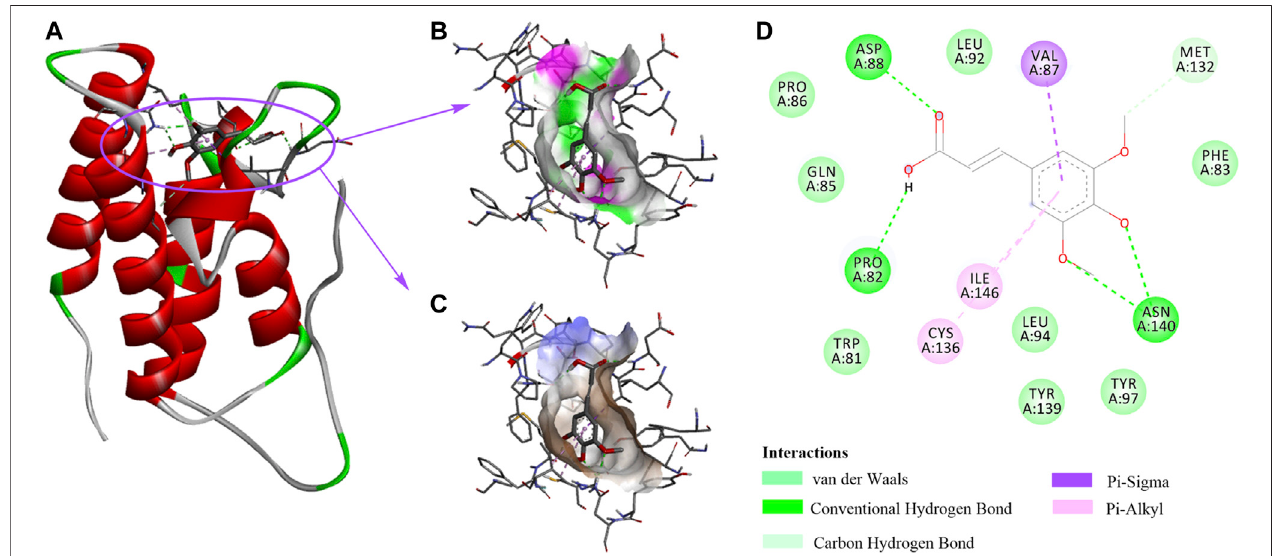
FIGURE 6 | The interactions between SA and BRD4. (A) 3D structure of BRD4 (PDB:3P5O) in complex with SA. (B) The strong hydrophilic regions are green. (C) The strong hydrophobic regions are orange. (D) The BRD4 and SA interaction network is composed of van der Waals, Hydrogen bonds, Carbon Hydrogen bond, and π